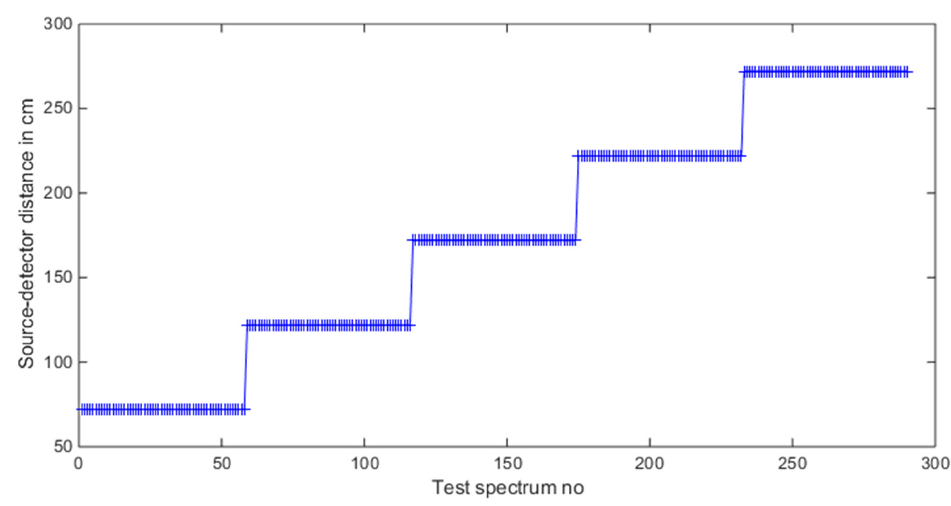
Figure 15. Source ‐ detector distance values in the test dataset. Figure 15. Source-detector distance values in the test dataset.